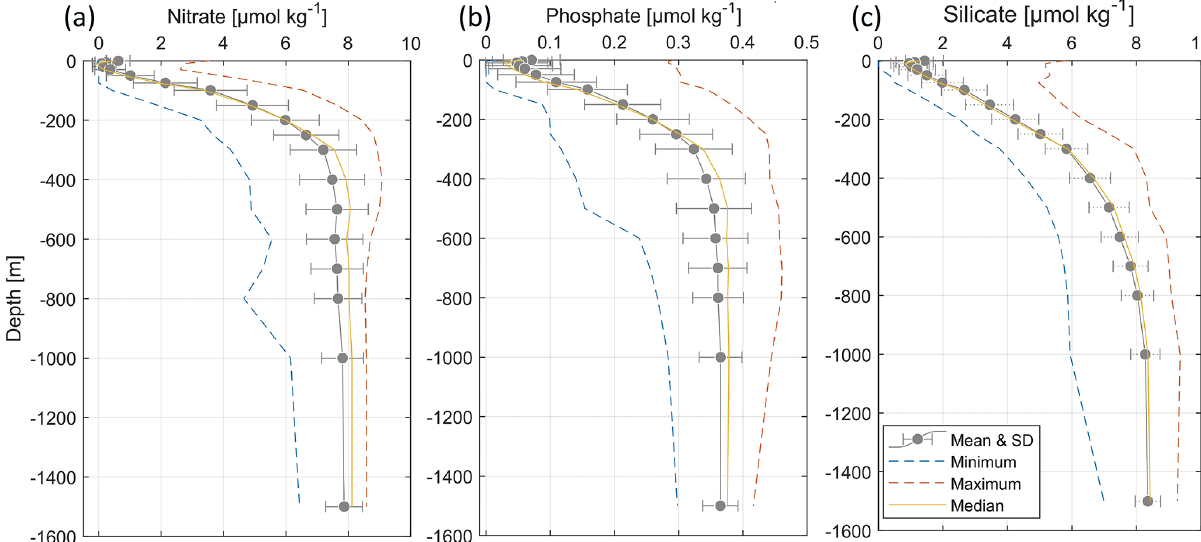
Figure 10. Climatological mean vertical profiles of (a) nitrate, (b) phosphate and (c) silicate concentrations in the WMED (1981–2017). The dashed blue line indicates the minimum; the dashed orange line indicates the maximum; the solid yellow line indicates the median profile; error bars and the mean profile are in